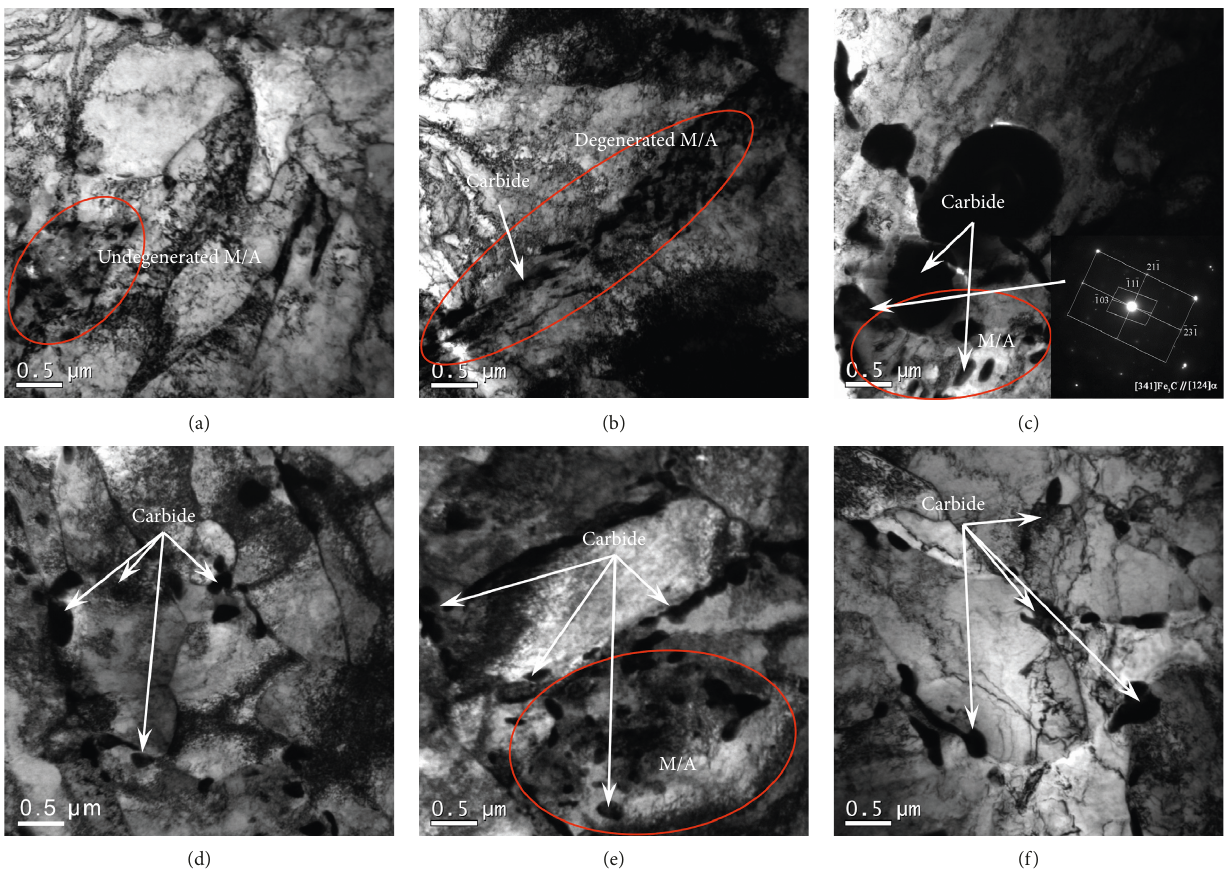
Figure 8: TEM micrographs of Bend C tempered at different temperatures: (a, b) 550 ° C; (c, d) 620 ° C; (e, f) 680 °